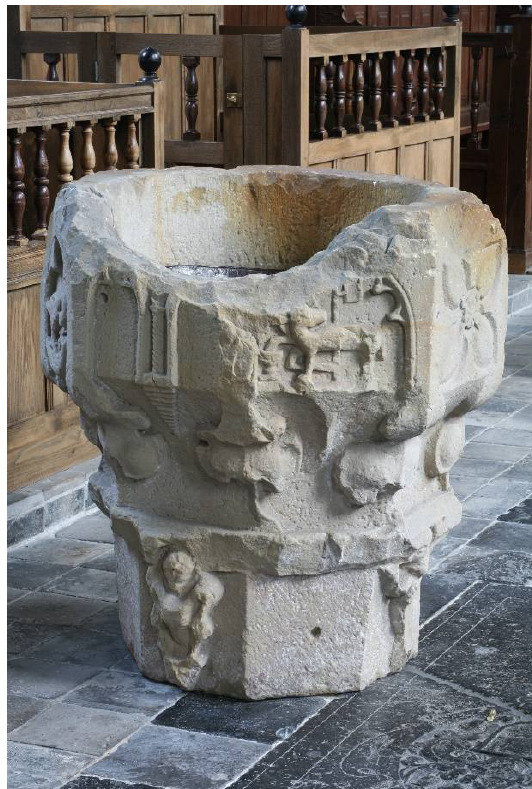
Figure 4. The stone baptismal font in Buitenpost (Frisia) was carved during the 15th century and heavily damaged during the 16th (photo: Regnerus Steensma archive).